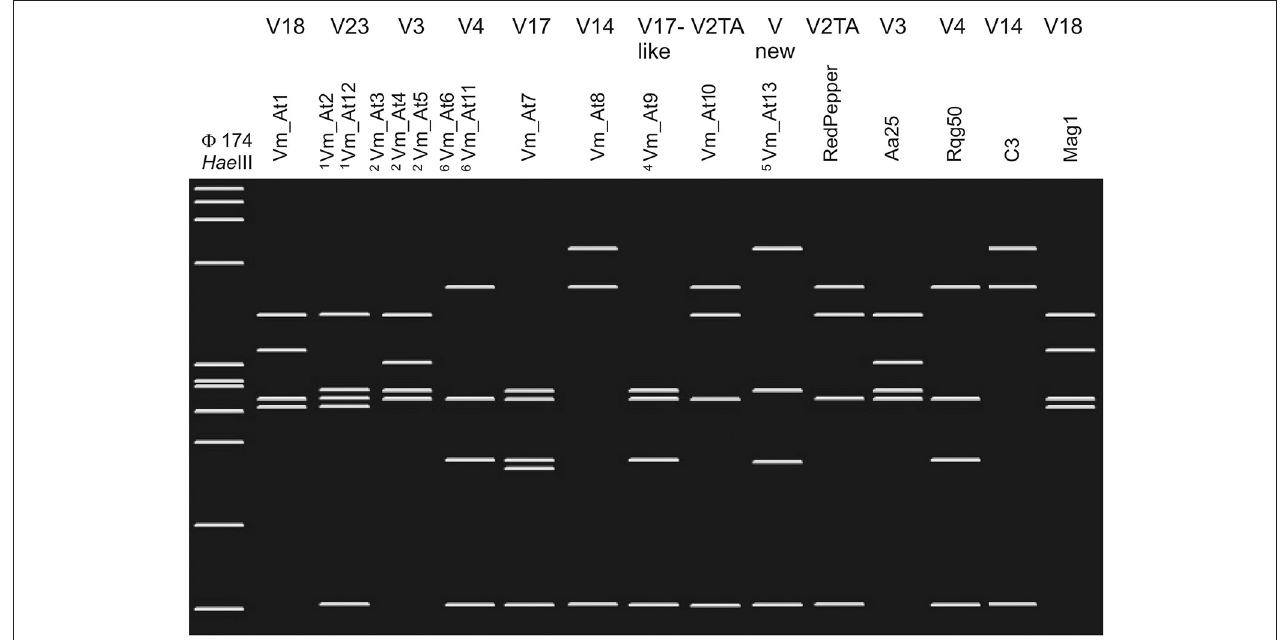
FIGURE 1 | Restriction fragment length polymorphism (RFLP) profiles were obtained after virtual Rsa I digestion of trimmed TYPH10F/TYPH10R PCR fragments of vmp1 of strains collected in vineyard environments in Austria and Slovenia (genotypes Vm_At1–Vm_At13) and the reference strains RedPepper, Aa25, Rqg50, C3, and Mag1. The patterns were generated by pDRAW32 1.1.147. The Rsa I-RFLP profiles are labeled on top with the V nomenclature as suggested by the SEE-ERA.NET nomenclature (Foissac et al., 2013). 1 Genotypes Vm_At2 and Vm_At12 show identical Rsa I-RFLP profiles. 2 Genotypes Vm_At3, Vm_At4, and Vm_At5 show identical Rsa I-RFLP profiles. 3 Genotypes Vm_At6 and Vm_At11 show identical Rsa I-RFLP profiles. 4 The Rsa I-profile of Vm_At9 has not been labeled in the V nomenclature, but the pattern is similar to the related V17 profile. 5 Virtual Rsa I digestion results in a novel profile. As marker Hae III digested ϕ X174 is shown on the left. The Fragment length from top to bottom are 1,353, 1,078, 872, 603, 310, 281, 271, 234, 194, 118, and 72 bp.